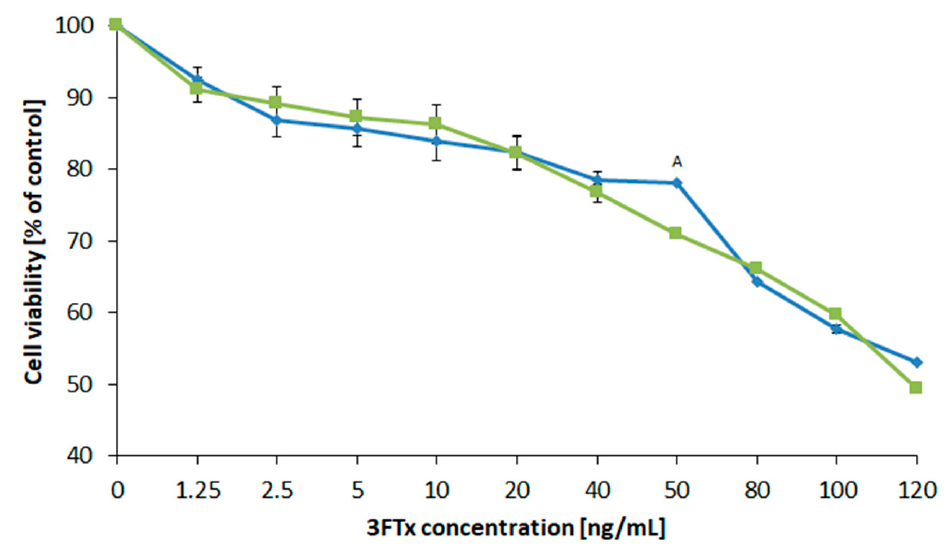
Figure 8. Viability of HL-60 (green color) and U-937 (blue color) cells. Values represent the average ± SD (n = 5). The letter A indicates a significant difference between the tested cell lines ( p ≤ 0.05).